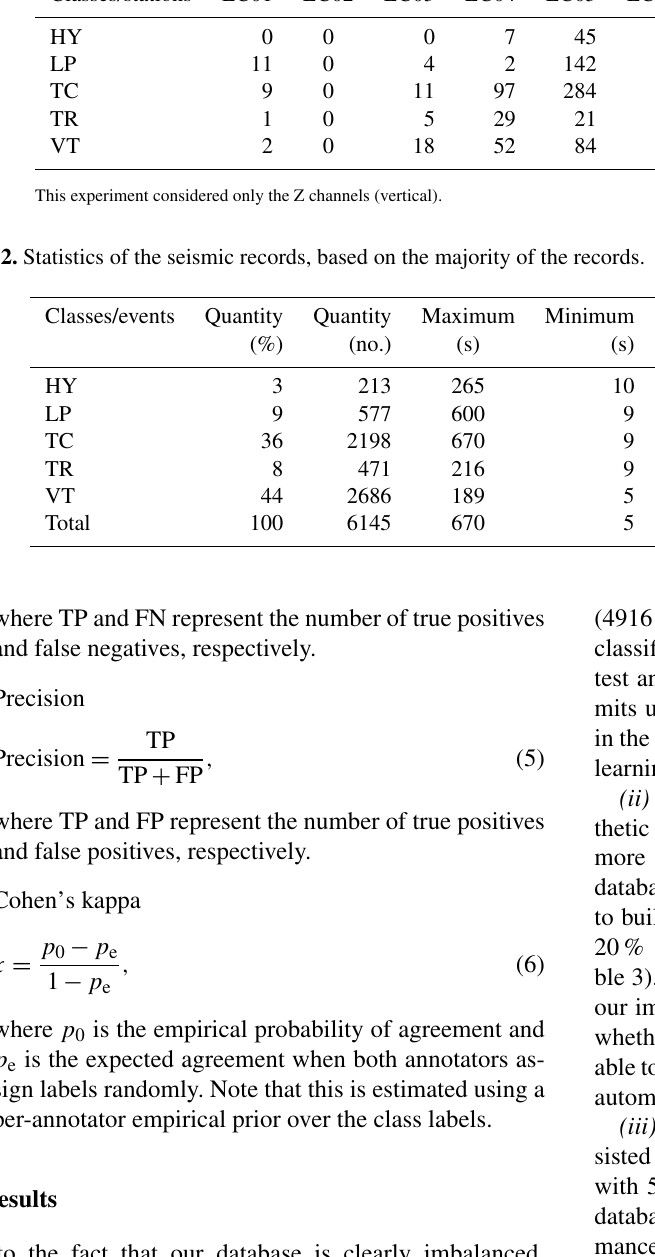
Table 1. Contribution of each station to Lascar’s database. Classes/stations